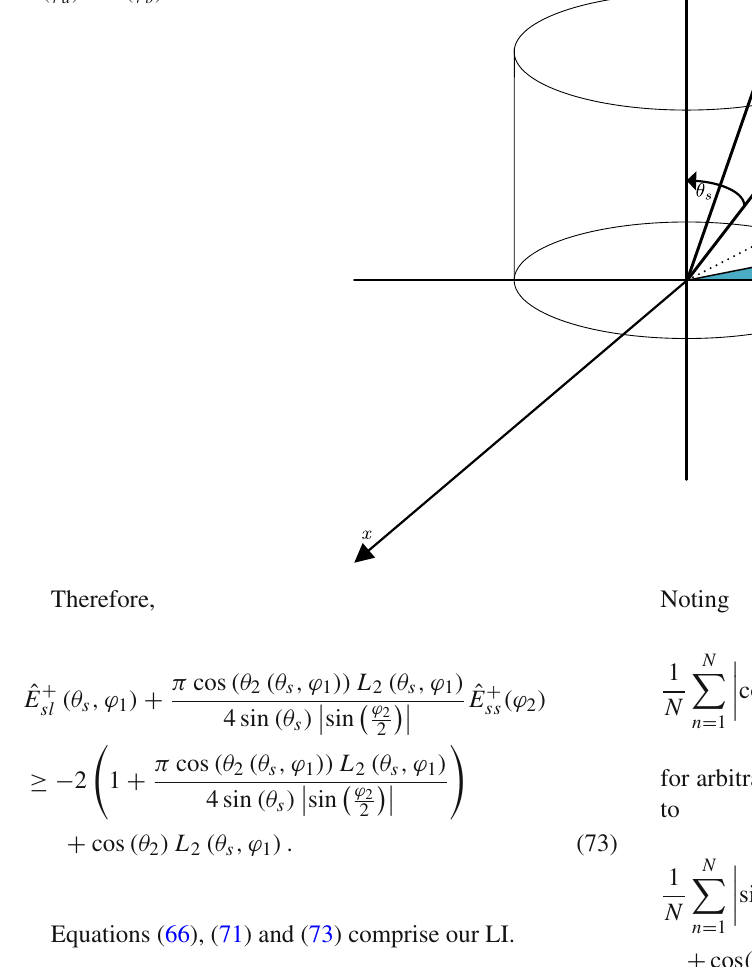
Fig. 7 Geometric relations of a s (φ a ) , a s (φ b )